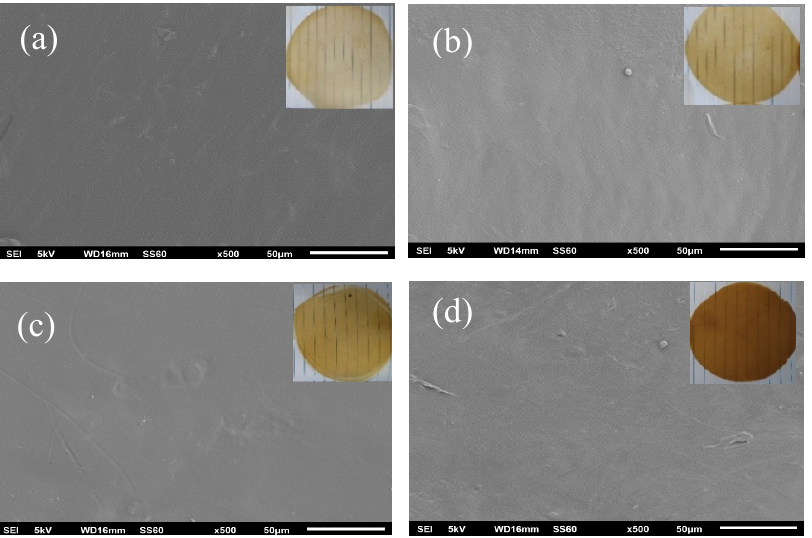
Figure 5. Morphology of ( a ) LDPE/CS_BO5, ( b ) LDPE/CS_BO10, ( c ) LDPE/CS_BO20, and ( d ) LDPE/CS_BO30 films. In the upper right part of each SEM image the photos of corresponding